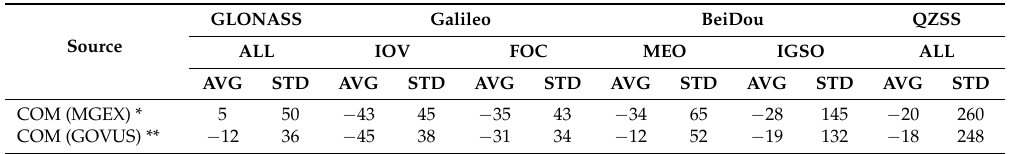
Table 2. SLR residual offsets (AVG) and standard deviations (STD) for the period 1 January–30 June 2016. Values in